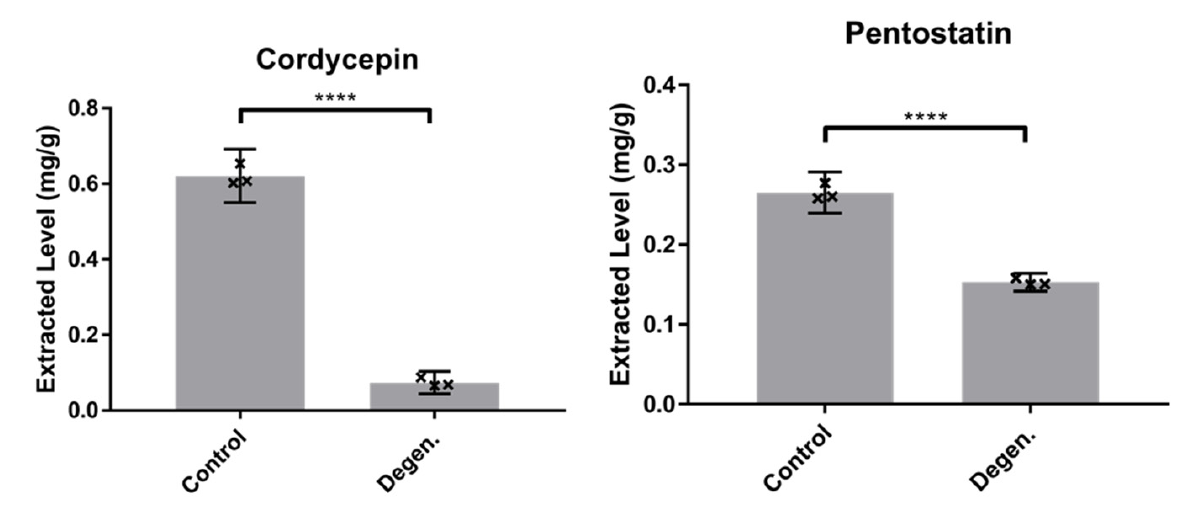
Figure 2. Cordycepin and pentostatin levels of control and degenerated CM2 strains as detected by LC-MS analysis. Levels are presented in mg/g fresh fungal material extractions from PDA (potato dextrose agar) plates. Error bars show 95% confidence intervals, and **** labels show significant differences ( p < 0.0001) as calculated using t -tests, with three biological replicates.